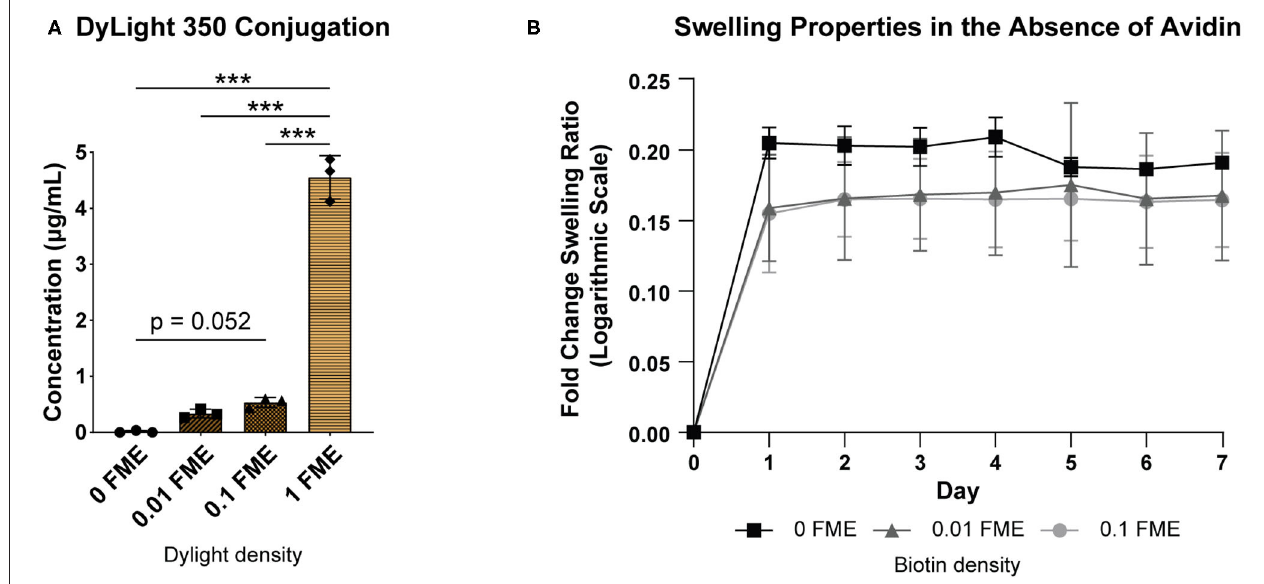
FIGURE 2 | Characterization of the effects of biotinylation on hydrogel properties. (A) Concentration of bound DyLight 350 in hydrogels prepared with 0.01, 0.1, and 1 FME NHS-DyLight 350. n = 3, mean ± SD. One-way ANOVA with Tukey’s post-hoc test (*** p < 0.001). ( B ) Swelling ratios of biotinylated hydrogels in PBS over 7 days. n = 2, mean ± SD. No statistical significance between groups or time points, determined using a two-way ANOVA with multiple comparisons post-hoc Tukey